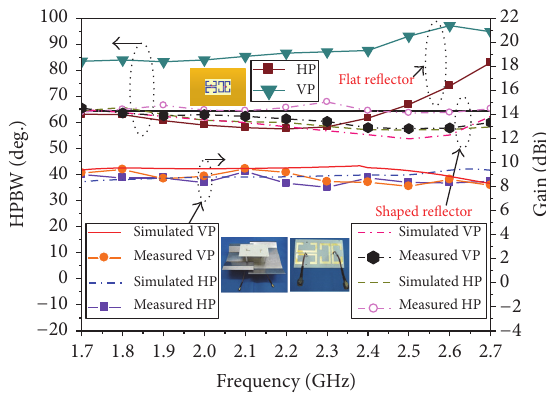
Figure 2: HPBWs and gains of the broadband V/H dual-polarized